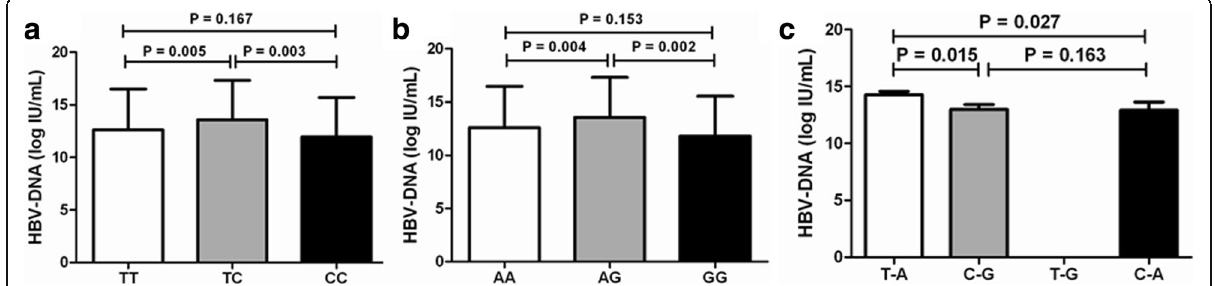
Fig. 1 Associations of rs1053004 ( a ) and rs1053005 ( b ) genotypes and rs1053004-rs1053005 haplotypes ( c ) with HBV DNA levels in patients with chronic HBV